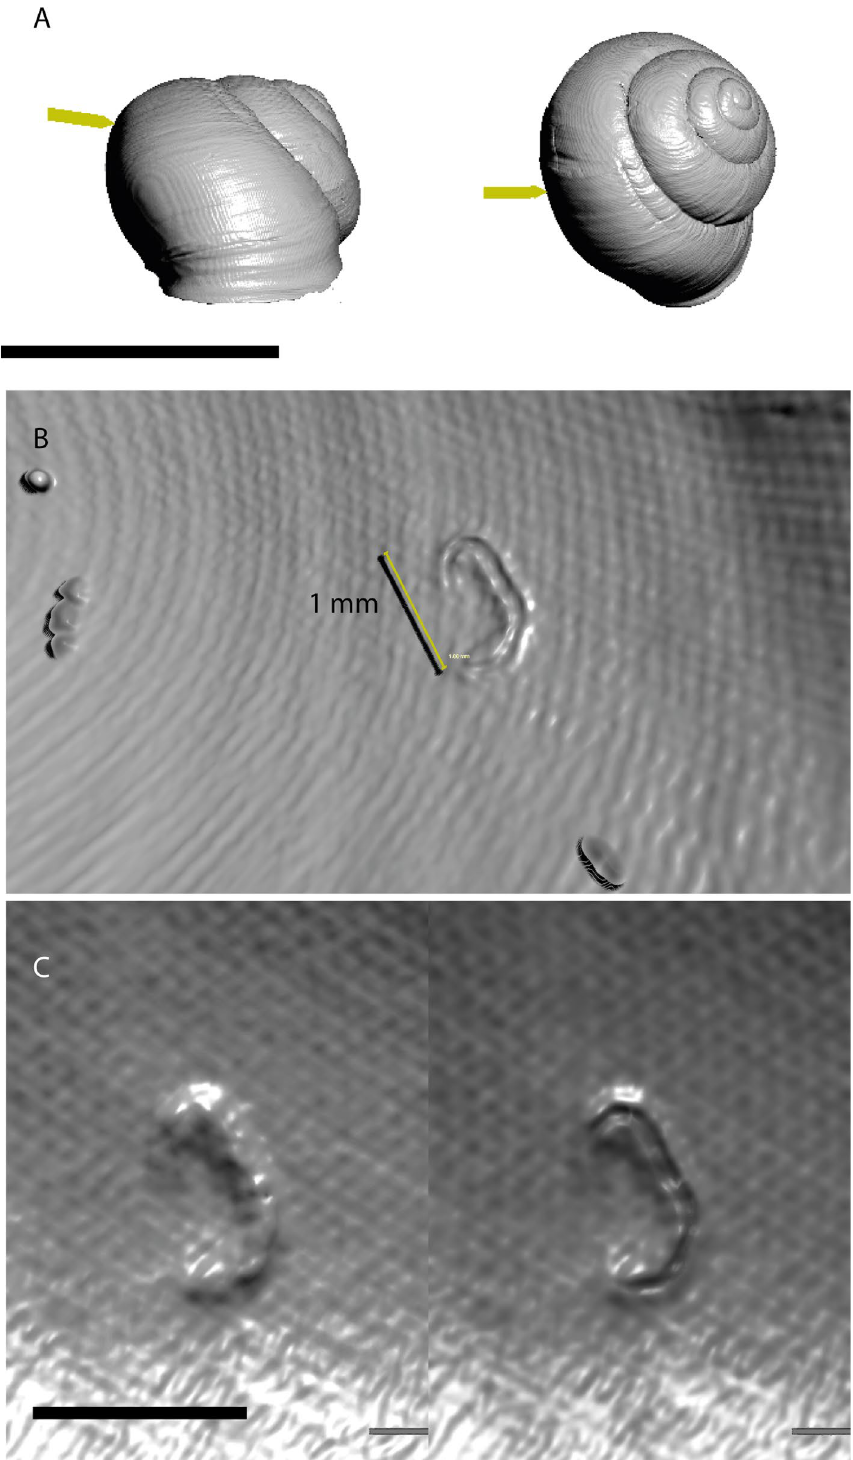
Figure 2. 3D views of the nematode encapsulation. ( A ) Arrows indicate location of the encapsulation in anterior and dorsal views of the shell. ( B ) The encapsulation inside the shell. Fine sand grains are also adhered to the inside of the shell and are visible. ( C ) 3D view of the encapsulation at two slightly different thresholds—on the left, a broader threshold window showing the complete nature of the encapsulation, and right, a narrower thresholding window exposing the internal geometry of the encapsulation. Scale bar = 20 mm in ( A ), and 1 mm in ( B , C